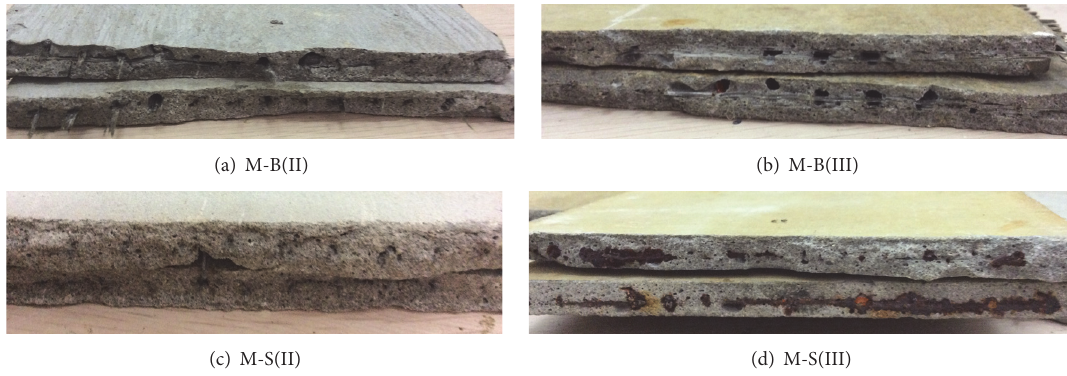
Figure 9: Fracture surfaces of the thin plates failed by bending tests.